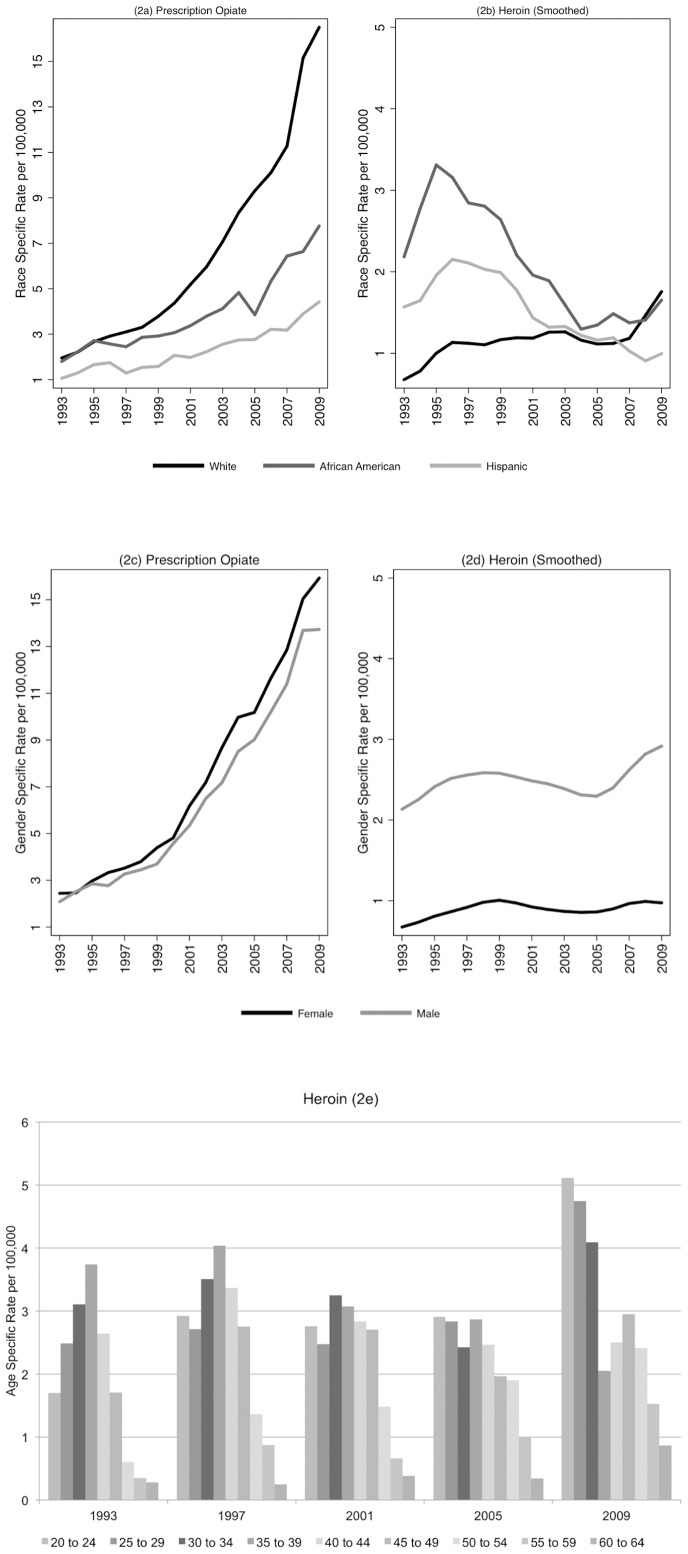
Demographic trends.